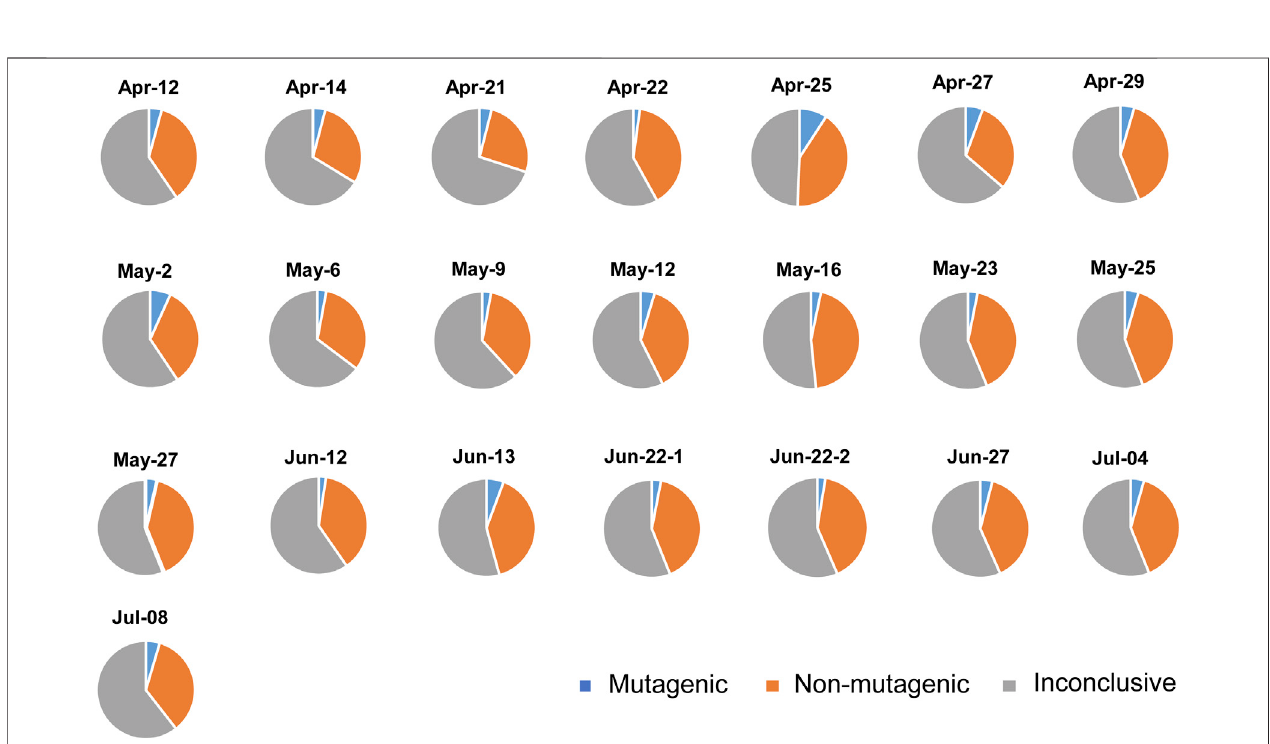
FIGURE2| Percentage ofcompounds classi fi ed in-silico asmutagenicand non-mutageniccompounds,ordonothave availableliteratureandhence classi fi edas inconclusive compounds.